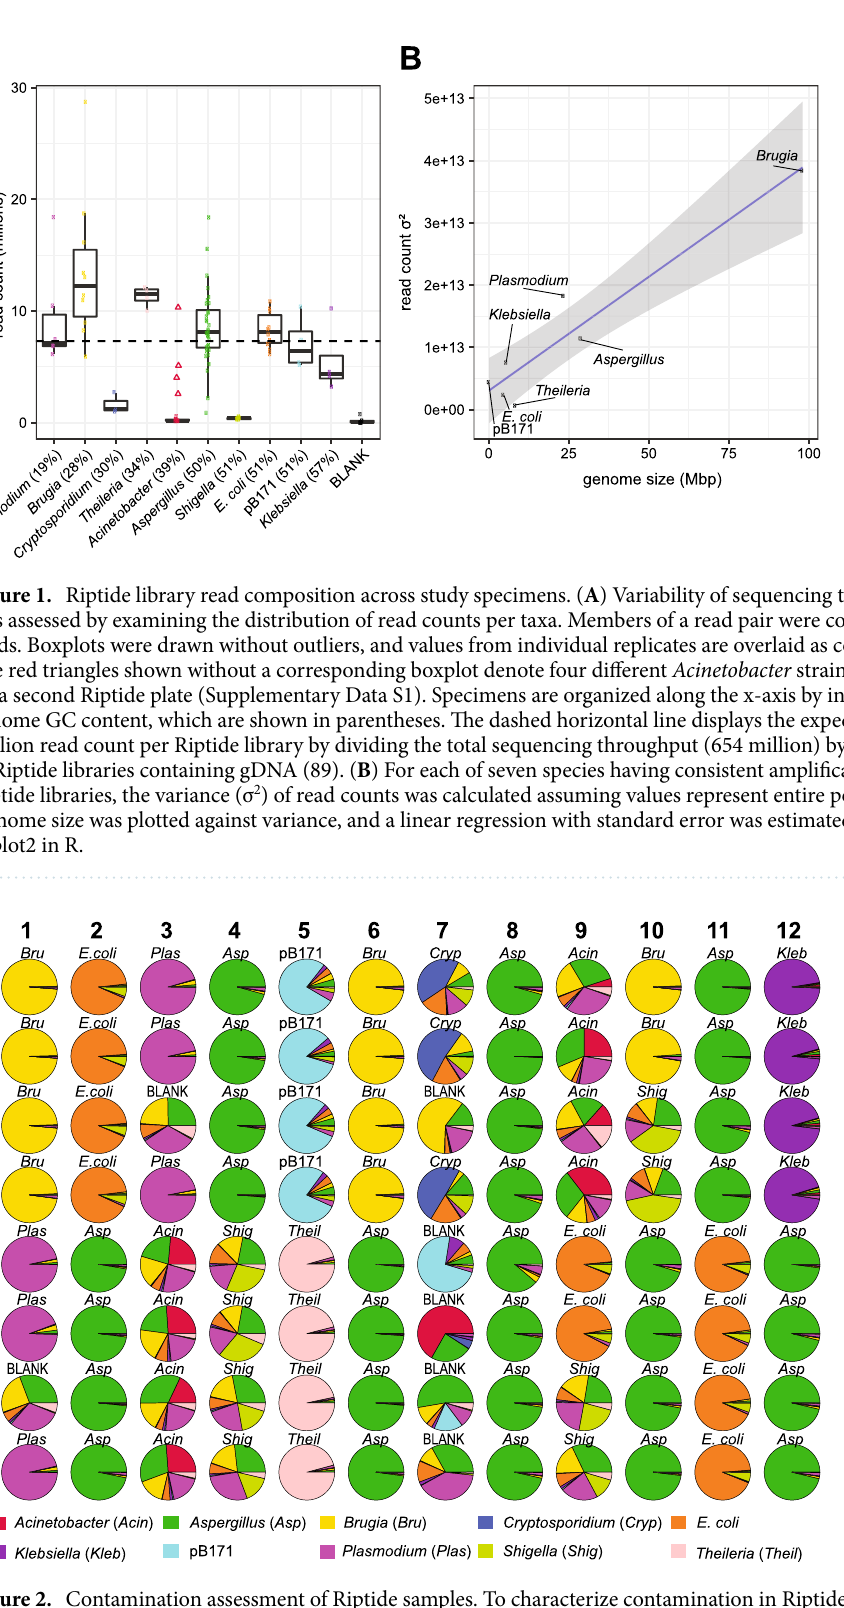
Figure 2. Contamination assessment of Riptide samples. To characterize contamination in Riptide libraries, primary reads were mapped to a reference containing genomes from all specimens used in the study. Pie charts display proportions of reads mapping to each genome. The figure is organized to represent the actual position of samples loaded on the Riptide 96-well plate. Wells are labeled according to source DNA used to prepare the Riptide libraries; wells containing no gDNA are labeled as